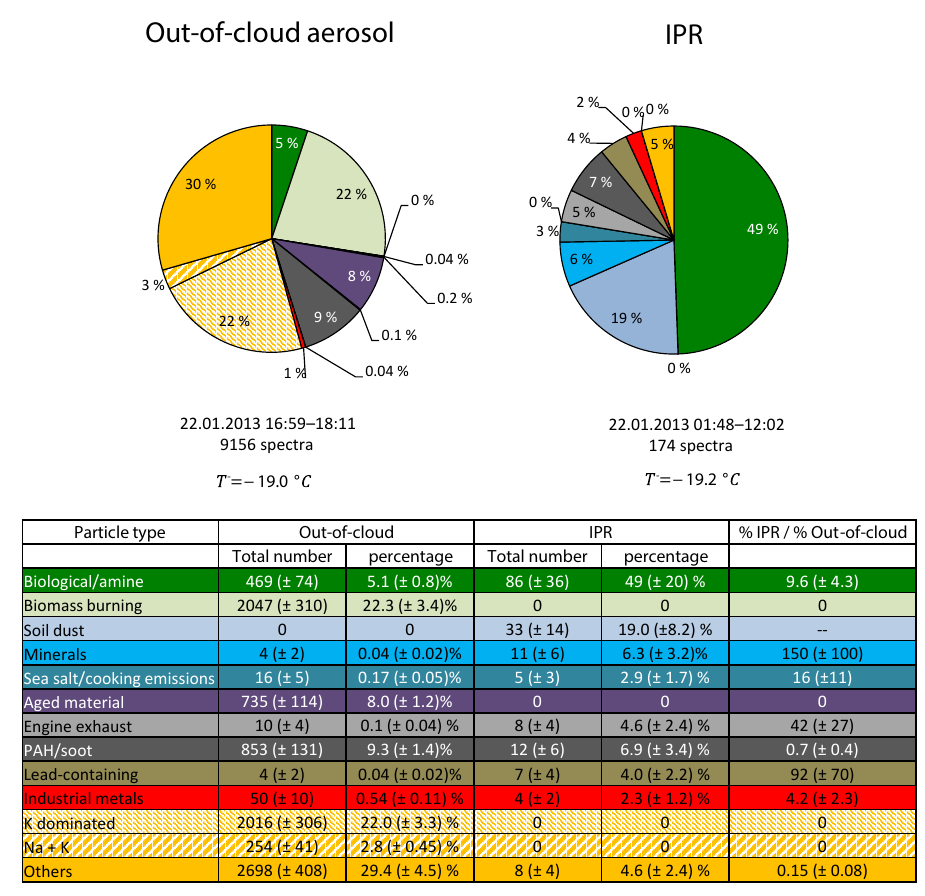
Figure 7. Comparison of the abundance of particles types in out-of-cloud aerosol (left) and the IPRs (right) at similar sampling conditions during each sampling period. The table lists absolute number of particles with uncertainties, percentages and enrichment factor (percentage IPR/percentage